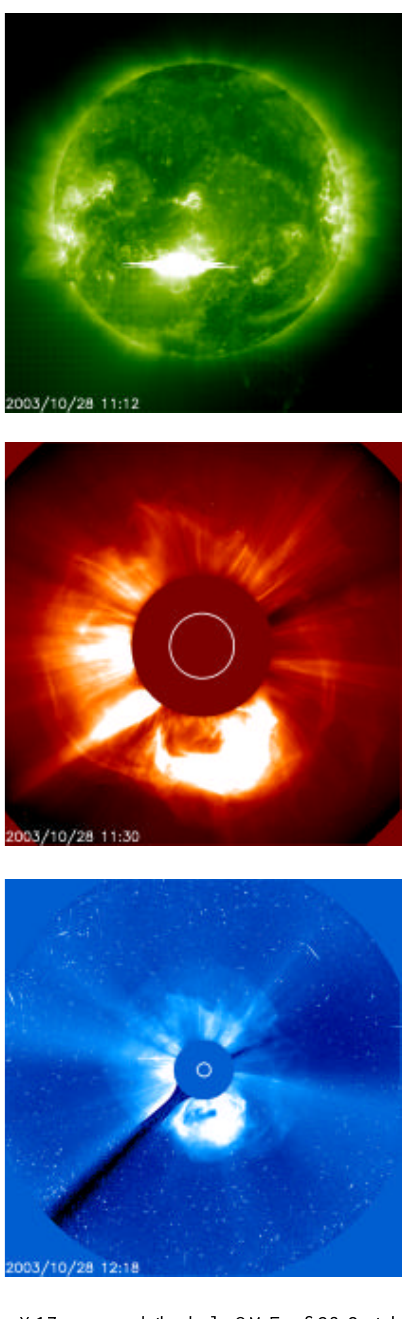
Figure 1. The X17 flare and the halo CME of 28 October 28, 2003, as seen by the SOHO Fig. 1. The X17 flare and the halo CME of 28 October 2003, as seen by the SOHO instruments EIT ( a ) , LASCO C2 ( b ) and C3 ( c ) . This most dramatic event caused major disturbances in space weather and affected the Earth’s system in various ways: charged particles were accelerated to near-relativistic energies, such that they could penetrate spacecraft skins and disturbed, for example, the CCD cameras on SOHO (see c) and other satellite instrumenta- tion; an extremely fast interplanetary shock wave was initiated that reached the Earth only 19h later; a severe geomagnetic storm (D st − 363nT) was launched, with bright aurora even all over Europe and the US. This was about 5h earlier than predicted using the tool described in this